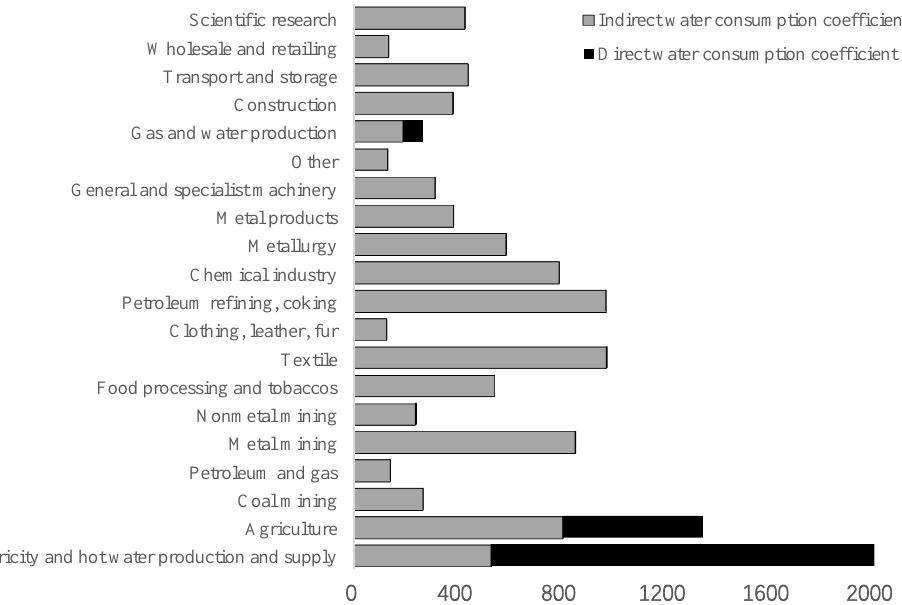
Figure 1. Direct, indirect and total water use coefficient of sectors in the Yellow River Economic Belt. (Source: Authors’ own calculation/conception, based on MATLAB software).